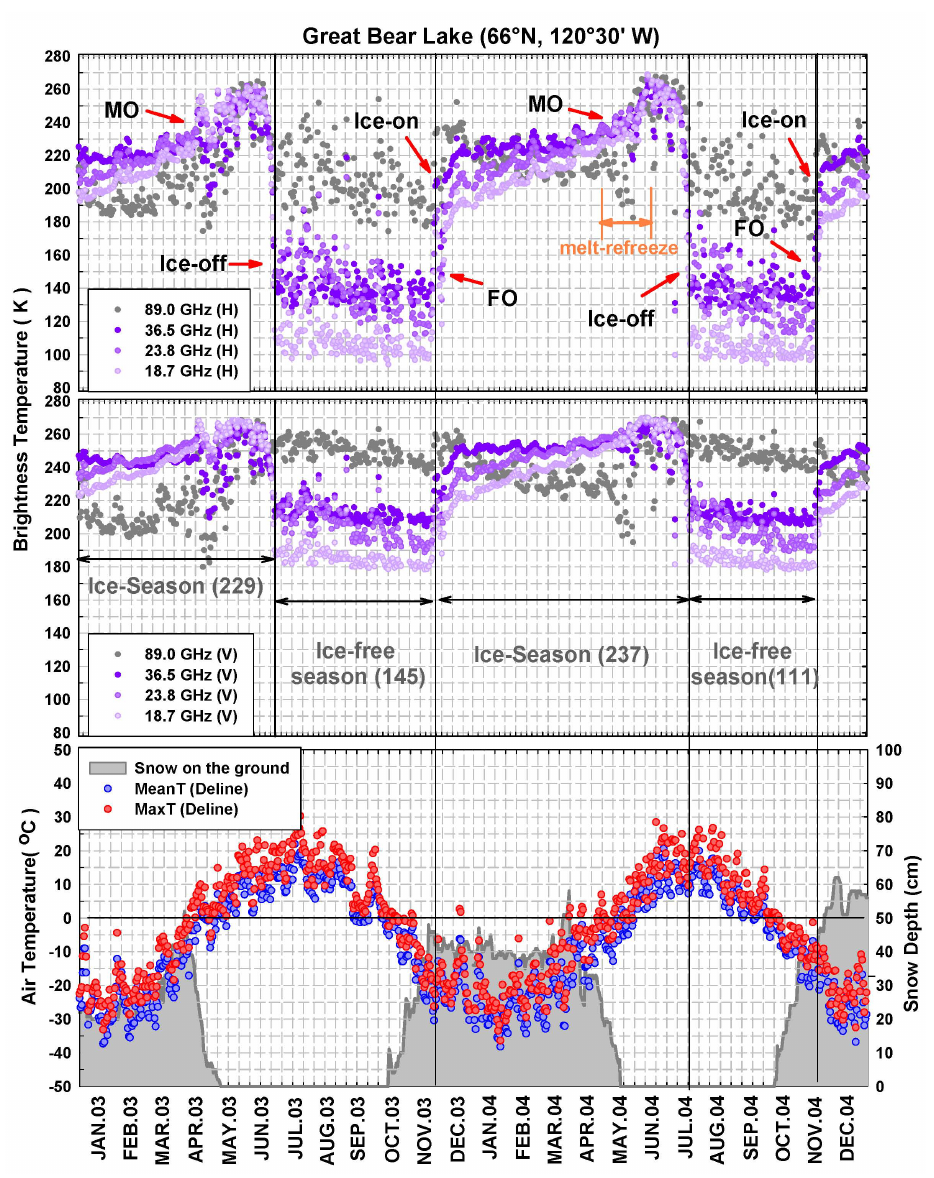
Fig. 2. Temporal evolution of horizontal (top) and vertical (middle) polarized brightness temperature at 18.7 (light violet), 23.8 (middle violet), 36.5 (dark violet), 89.0 (dark grey)GHz (2003–2004) for sampling site on GBL (see Fig. 1). The time series of maximum (Max T, red) and mean (Mean T, blue) air temperatures obtained at Deline meteorological station is shown in the bottom panel of the figure, with snow depth as grey shaded area. Numbers after both “Ice Season” and “Ice-free Season” indicate number of